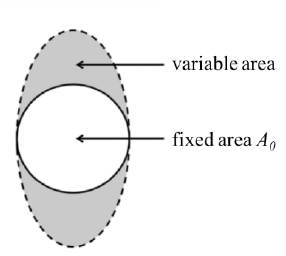
Figure 2. Fixed and variable areas of a